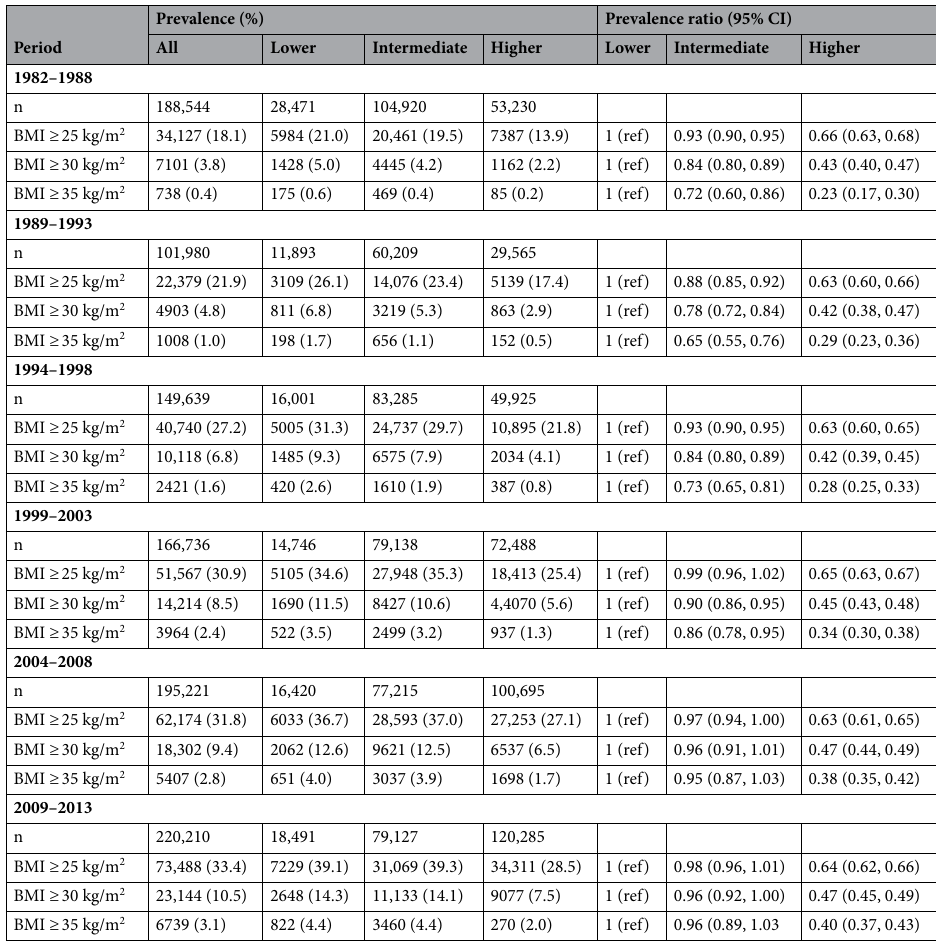
Table 2. Age-adjusted prevalence and prevalence ratios of overweight, moderate and severe obesity, by period and education. Age-adjusted prevalence ratios with corresponding confidence intervals was calculated for overweight, moderate and severe obesity comparing lower versus intermediate and higher level of education within each period. CI confidence intervals, n number of individuals, BMI body mass index, ref